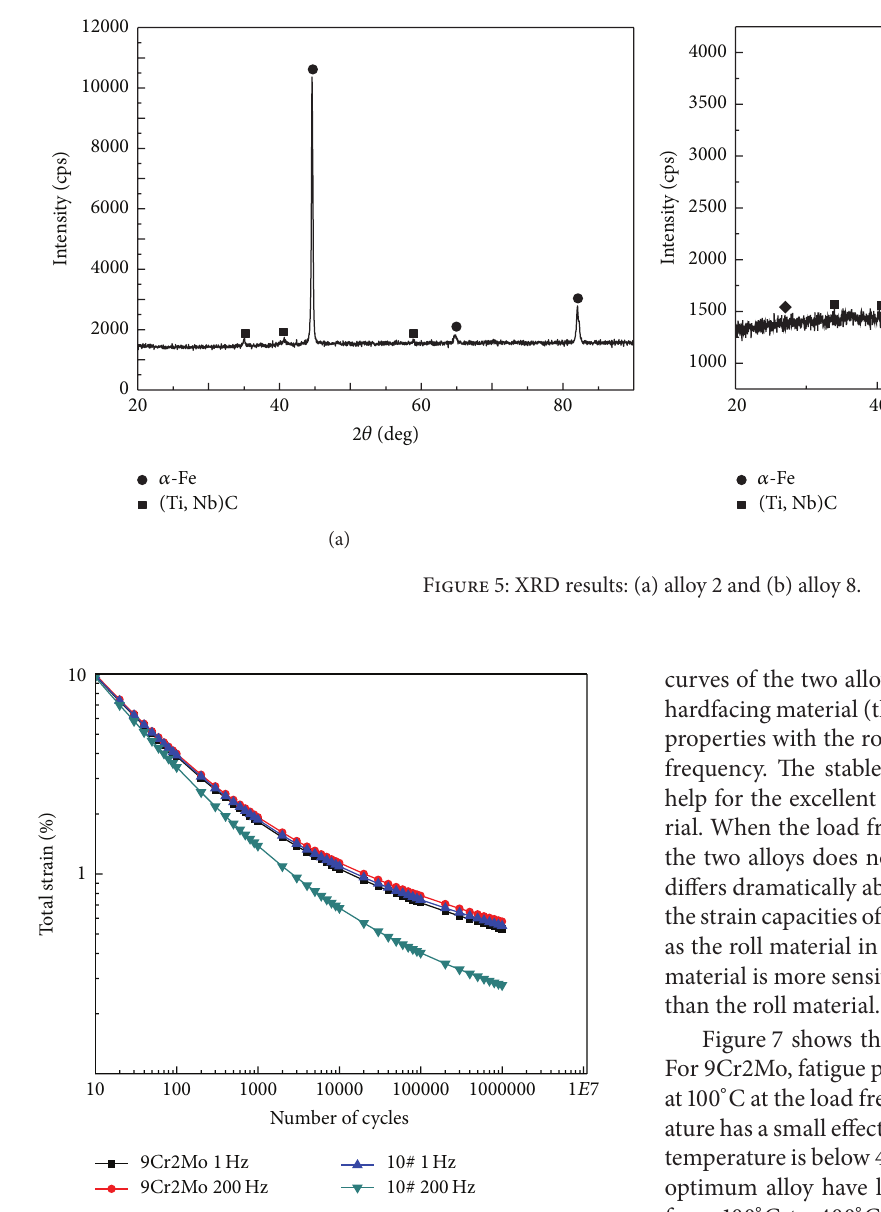
Figure6: Δ𝜀 - 𝑁 curvesofalloy9Cr2Moandtheoptimumalloy(10#) under different load frequency at 400 ∘